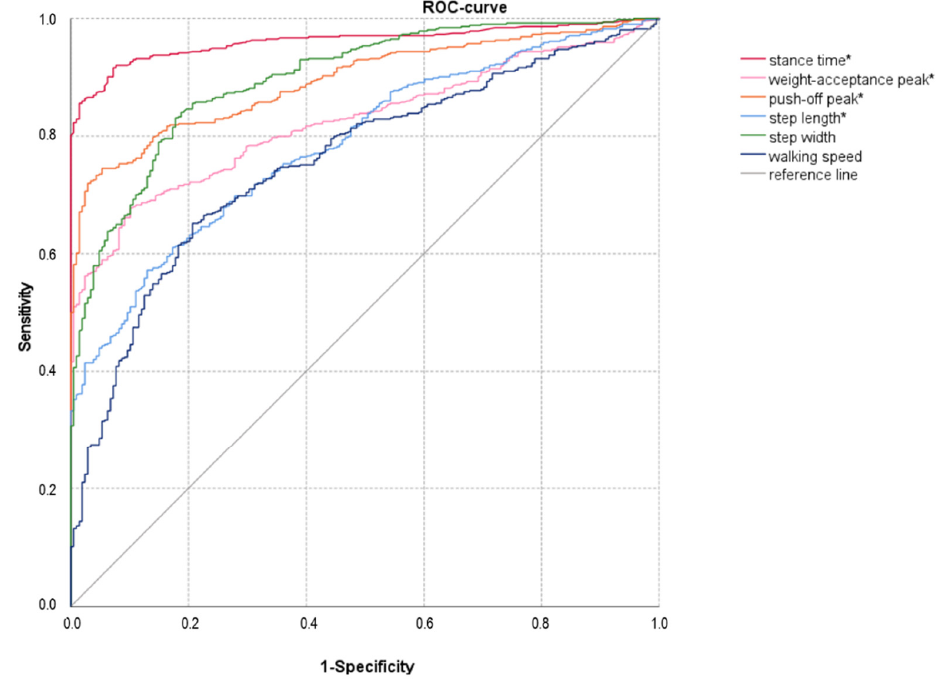
Figure 2. Sensitivity and specificity of kinetic gait parameters in patients with ULLA (* difference between intact and affected side).